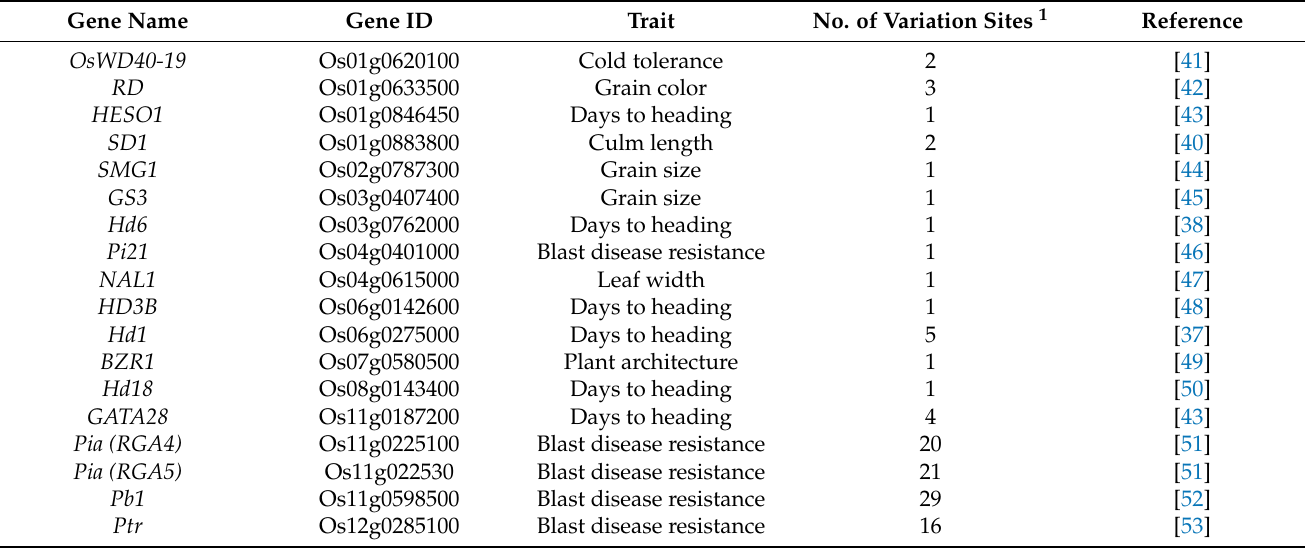
Table 4. Summary of sequence variations in well-known agronomically important